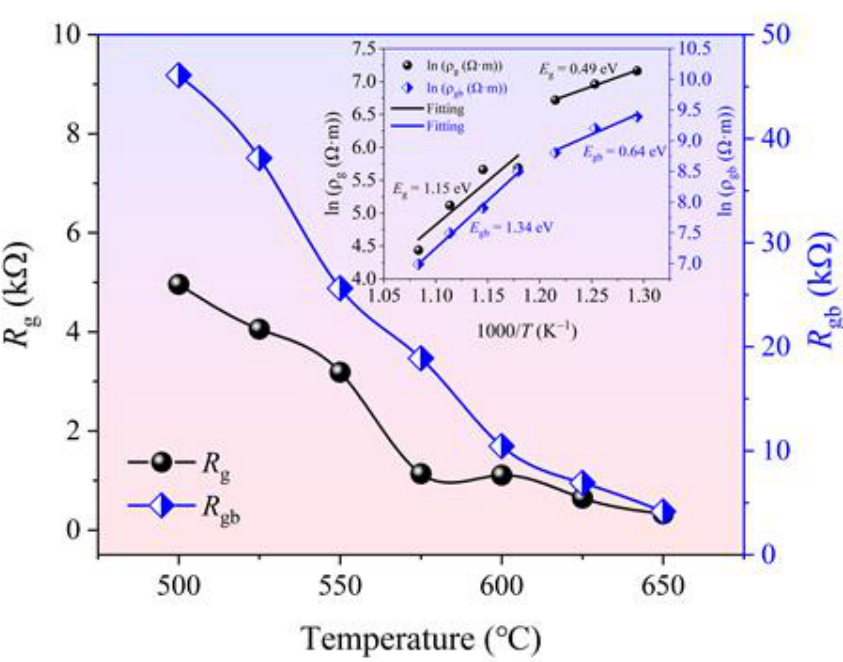
Figure 6. Temperature dependence of R g and R gb of the BGTN − 0.2Cr ceramic (inset shows the Arrhenius fitting of the plots of resistivity vs. temperature).